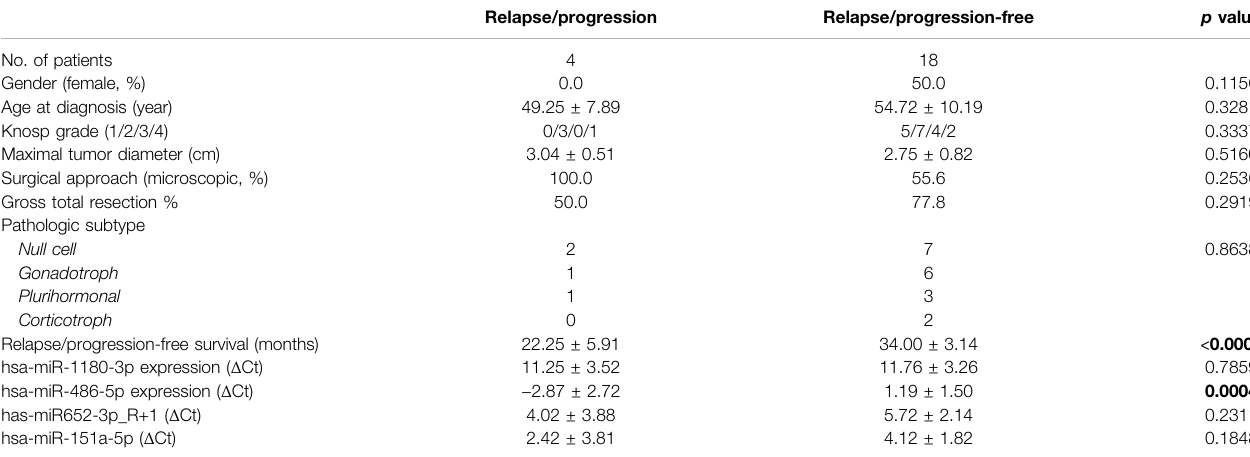
Relapse/progression